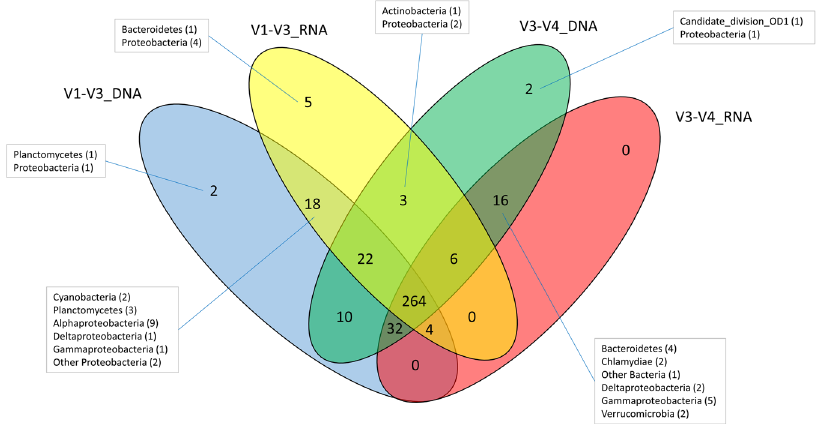
Figure 3. Venn diagram revealing the number of shared and unique genera in the different datasets. In total 384 different genera were identified in this analysis. Phyla unique to the different datasets are described in the outlined boxes with the number of different genera per phyla within